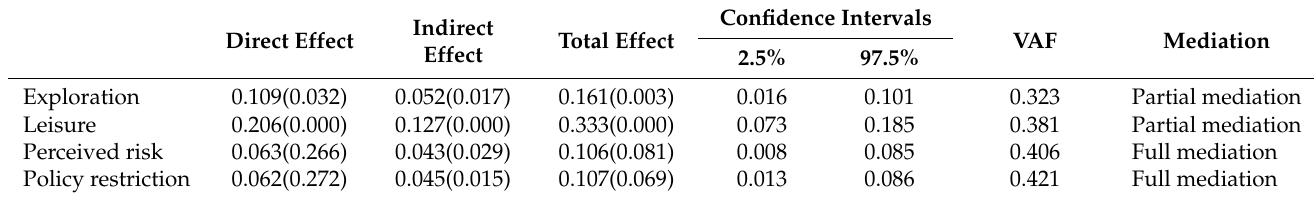
Table 6. Effect deconstruction of the structural